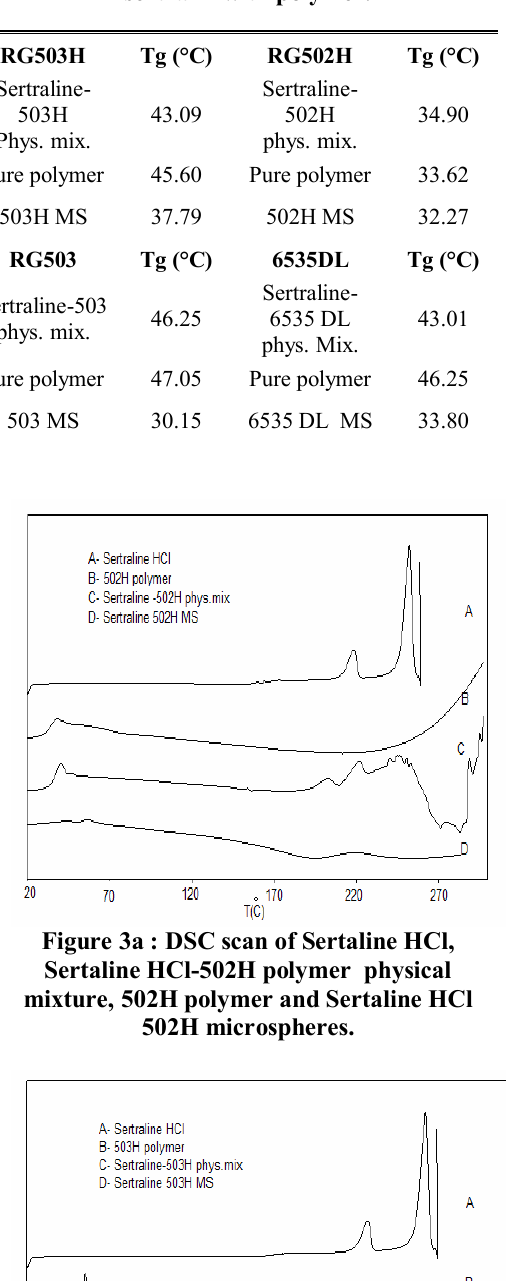
Table 2 : The Tg of the Sertraline bpowder, microsphere and the physical mixture of sertralin with polymer.